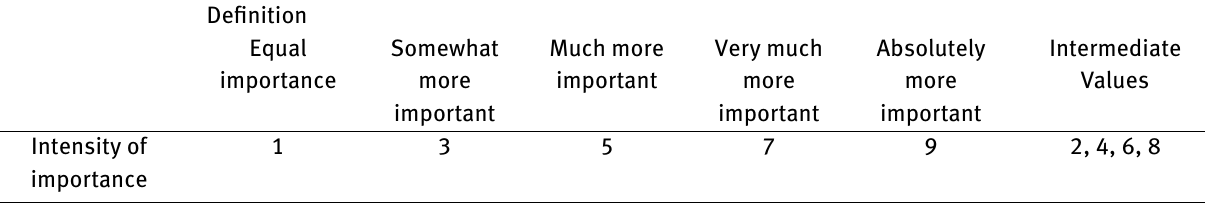
Table 7: One common scale (adapted from Saaty) used in this